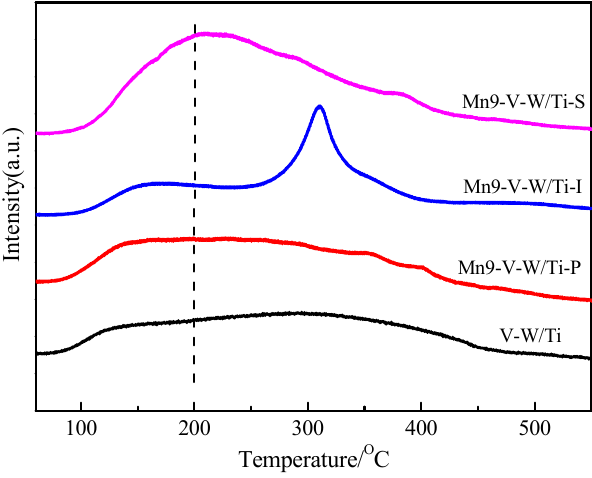
Figure 8. NH 3 -TPD profiles of the catalysts. Reaction conditions: purging the catalysts with N 2 at 110 °C; NH 3 was adsorbed at 50 °C; NH 3 was desorption at 50 – 550 °C, the heating rate is 5 °C/min.